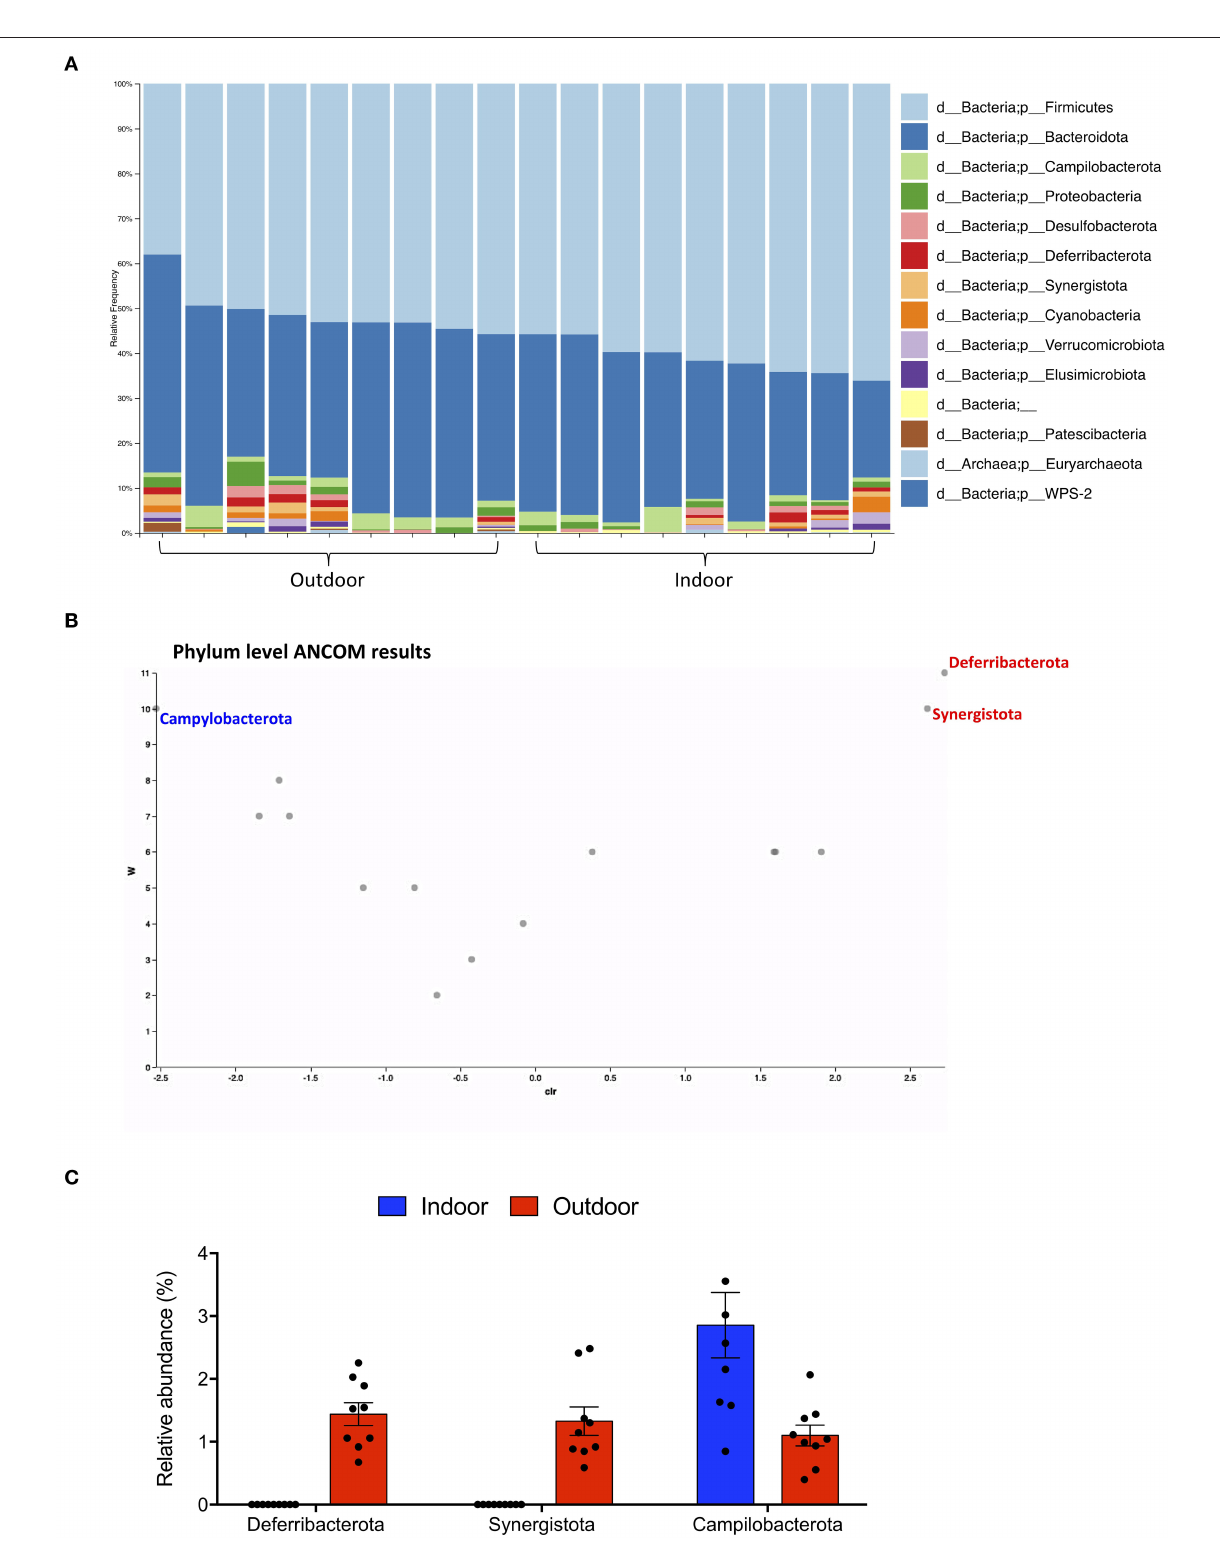
Frontiers in Veterinary Science |